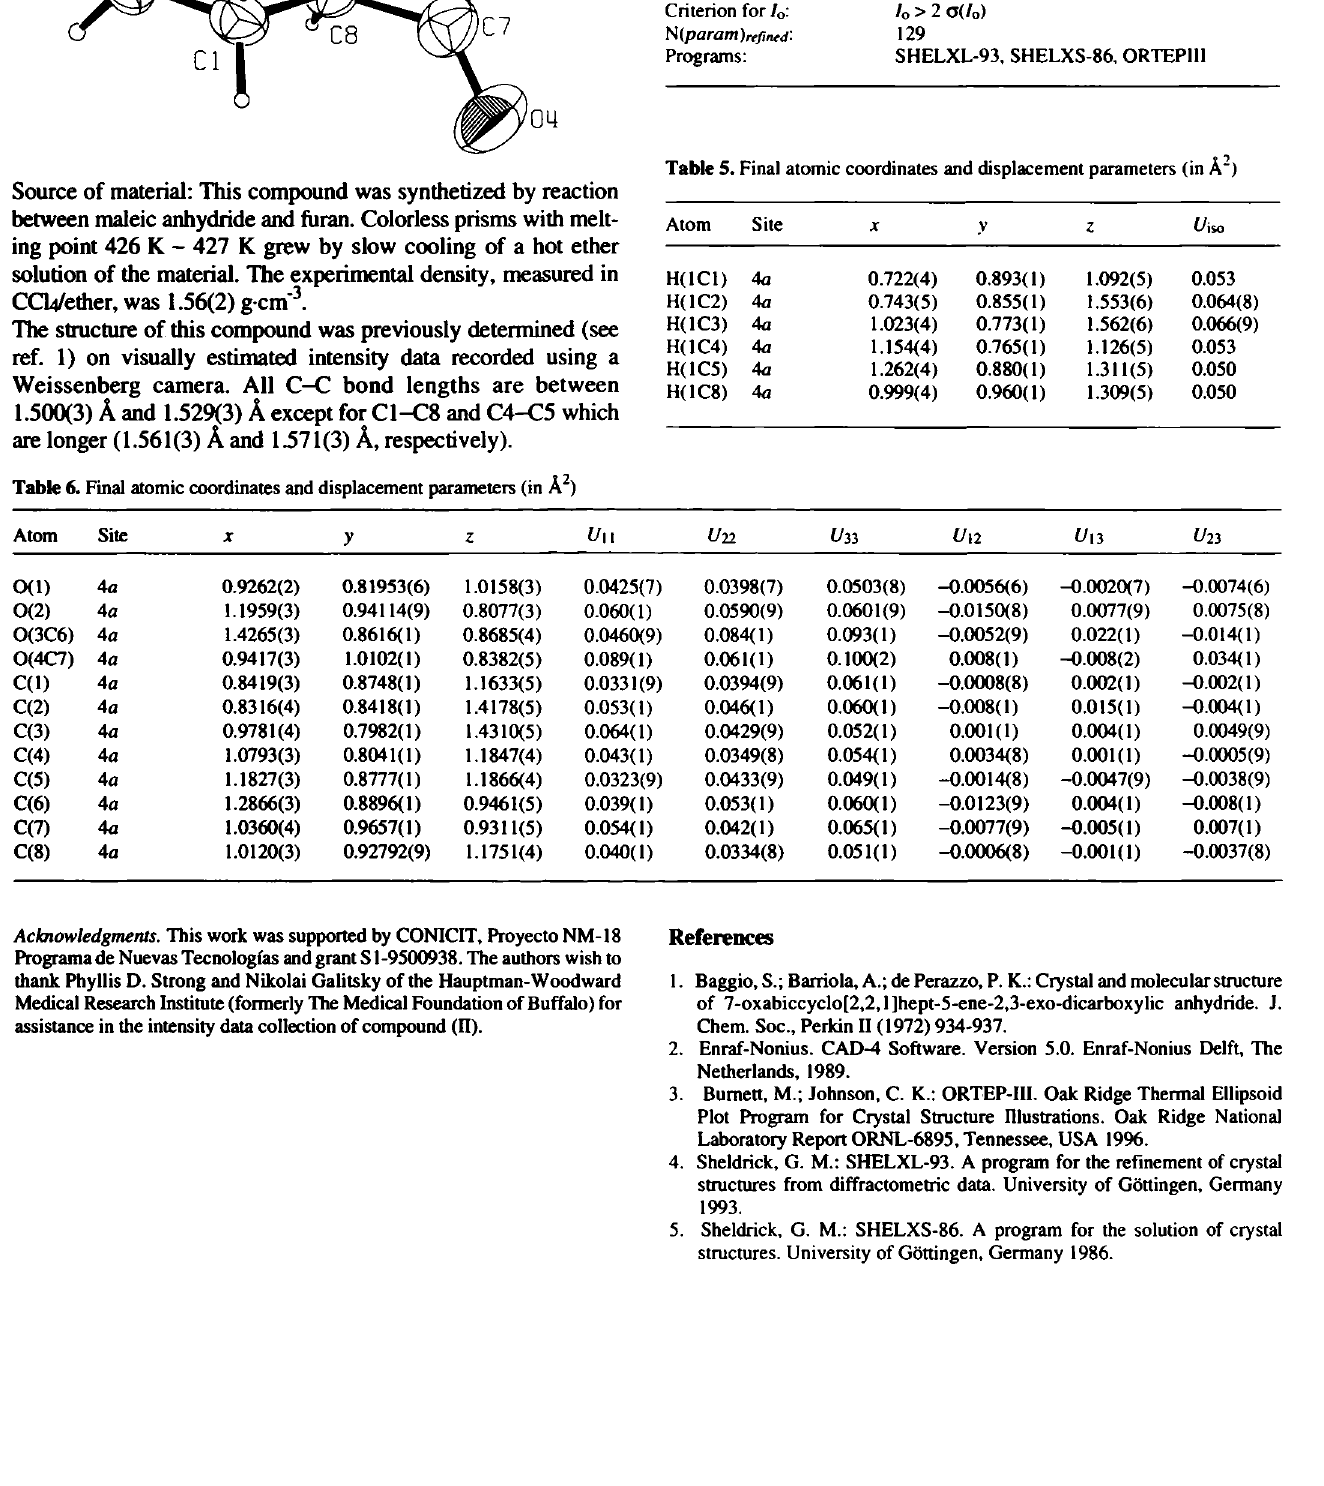
Table 4. Parameters used for the X-ray dau collection Crystal: